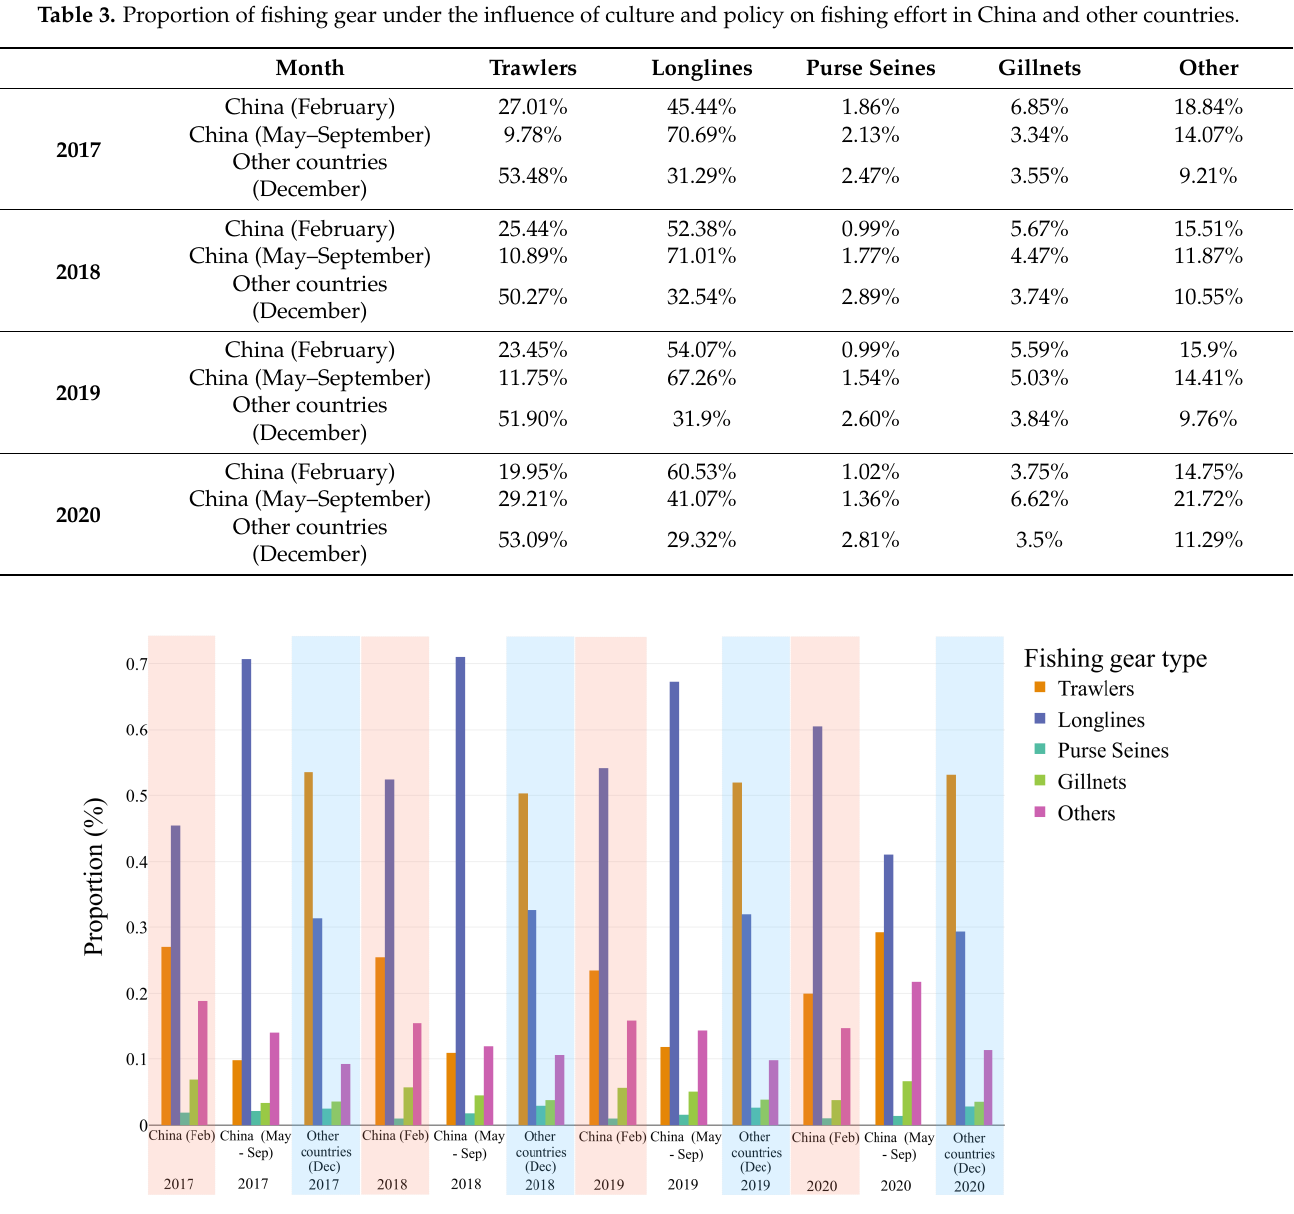
Figure 10. Comparative plots for 2017 to 2020 of the proportion of fishing gear under the influence of culture and policy on fishing effort in China and other countries for specific months (Feb and Dec for culture; May to Sep for policy).